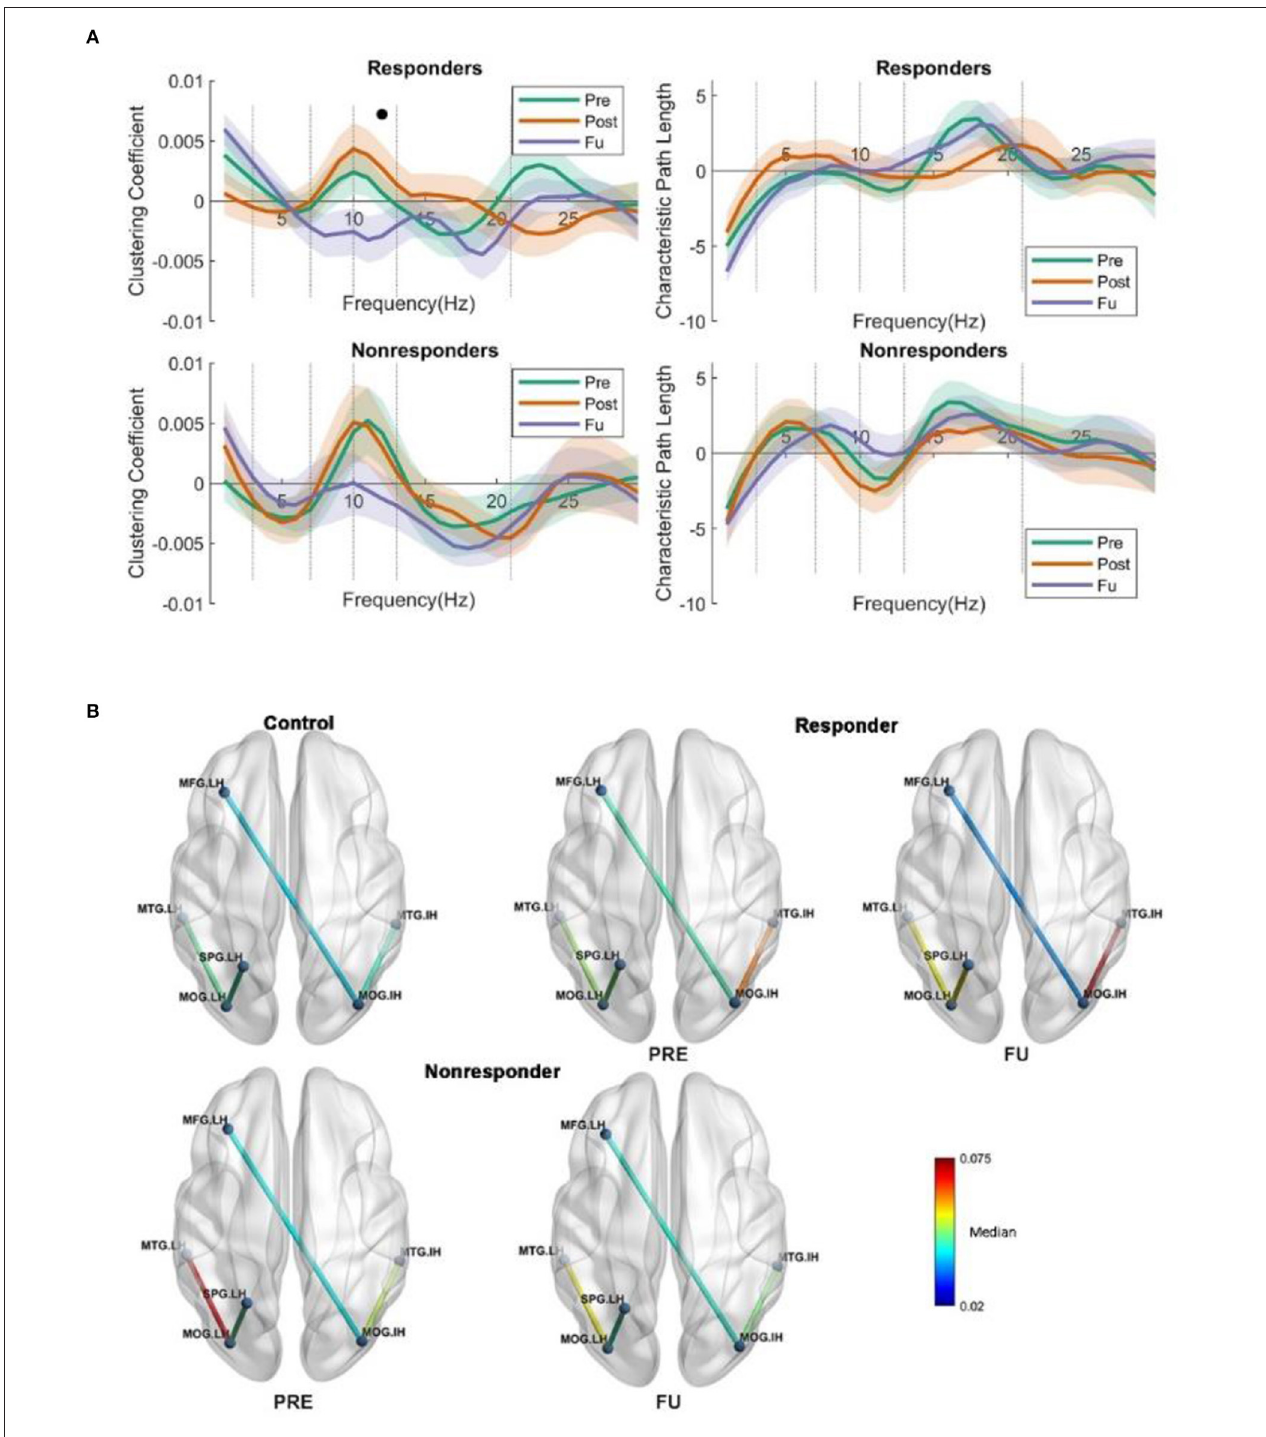
FIGURE 5 | (A) Global clustering coefficient and CPL show no interaction or main effect for characteristics path length (two groups/three time points). But a main effect was observed in the responders when comparing FU and POST, namely, a lower clustering coefficient. (B) The global coherence. From (B) , we could see the strength of the intact middle occipital increased, whereas the centrality decreased, which is very interesting; we may suggest that intact middle occipital gets rid of redundant connections from various regions but enhanced the connection with intact temporal lobe, as the temporal lobe could help the vision loss patient to handle the daily perception or movement identification. The long coherence between lesion frontal and intact occipital was observed significantly reduced at FU; the coherence was lower than that in PRE in the alpha band. The coherence between the lesion temporal and lesion occipital was significantly changed; both the responders and non-responders show higher coherence than the control